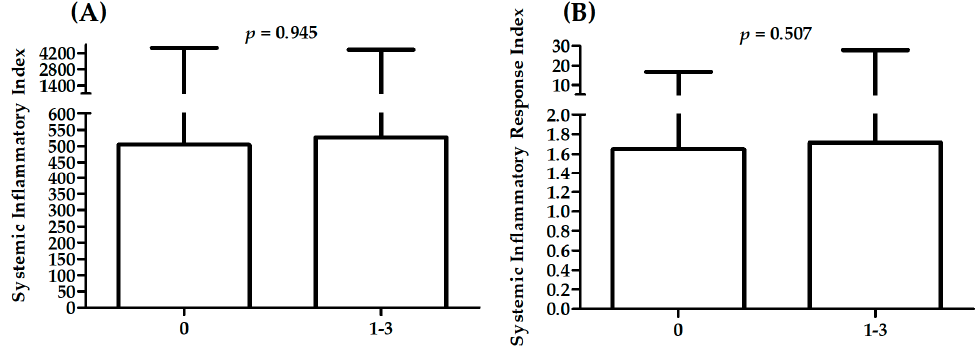
Figure 2. Differences in SII ( A ) and SIRI ( B ) between patients with CASSC 0 and CASSC 1–3.